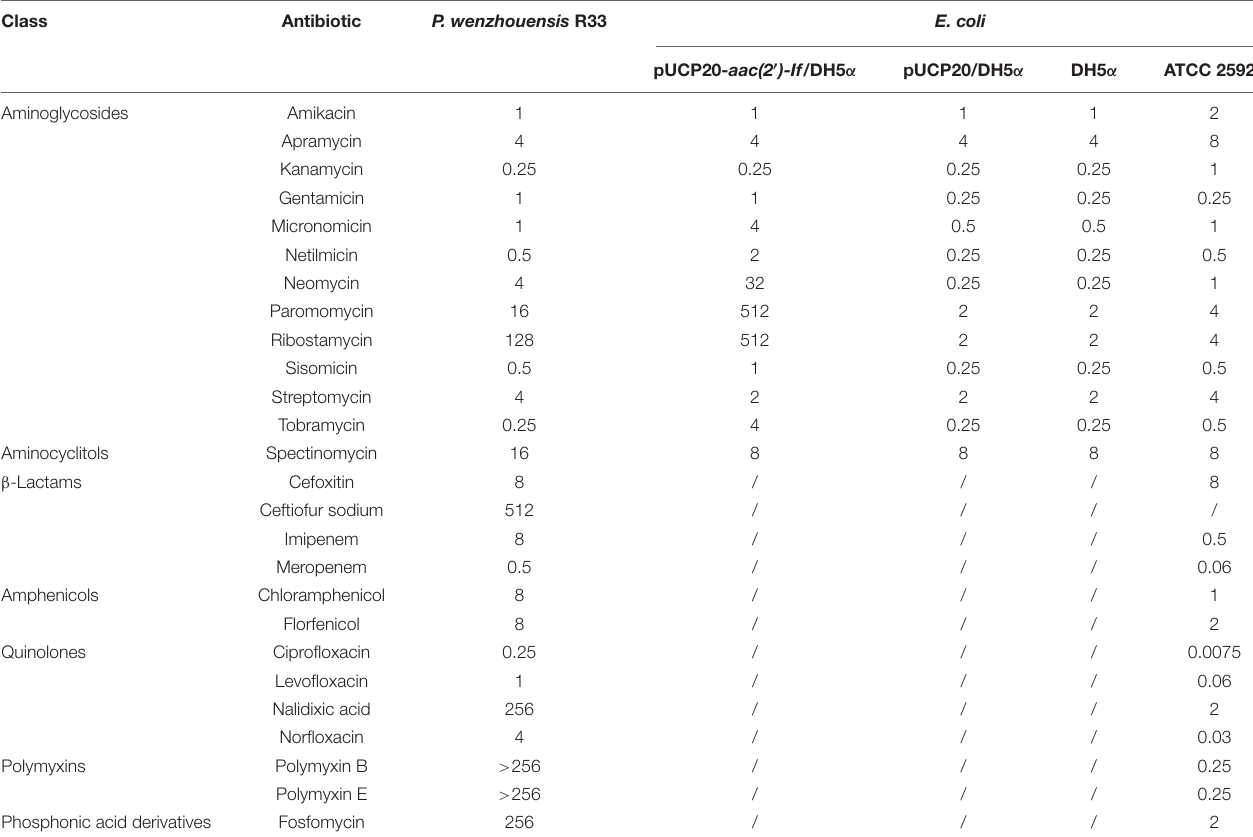
TABLE 2 | MICs of various antibiotics for five bacterial strains ( µ g/mL). Class